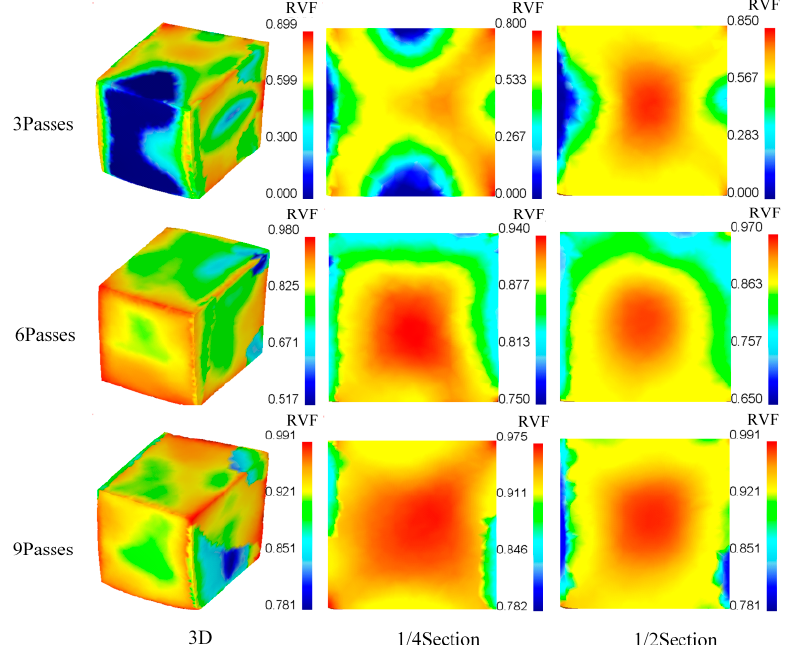
Figure 12. Dynamic recrystallization volume fraction cloud diagram for three to nine passes forging at 800 °C.